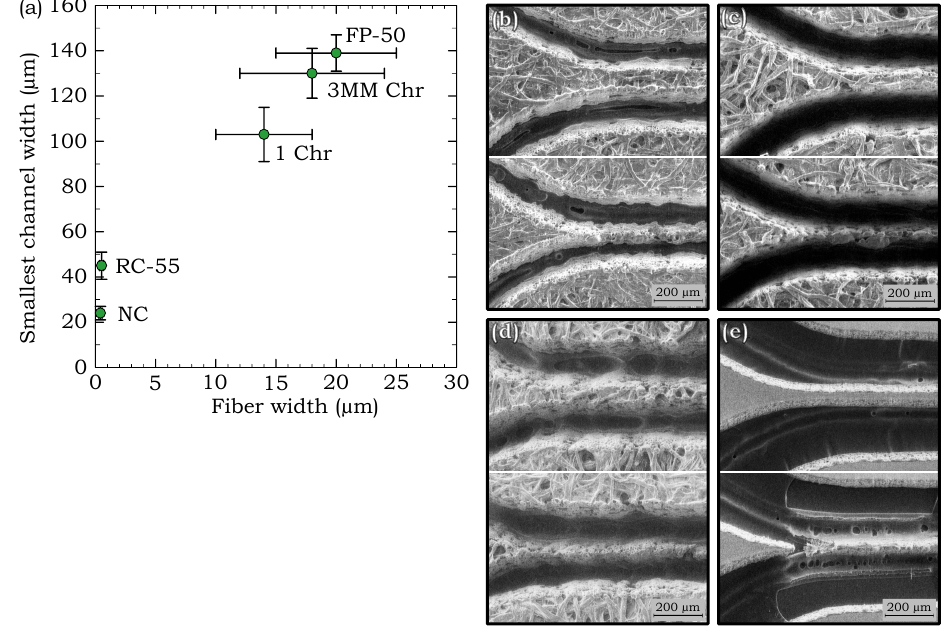
Figure 5. ( a ) The smallest channel widths in each of the paper types for successful fluid flow plotted against fiber widths. SEM images of the channels generated in the different paper types showing one intact channel with successful fluid flow (on the top) and one narrower channel where fluid flow was not successful (on the bottom), for ( b ) FP-50, ( c ) 3MM Chr, ( d ) 1 Chr, and ( e )